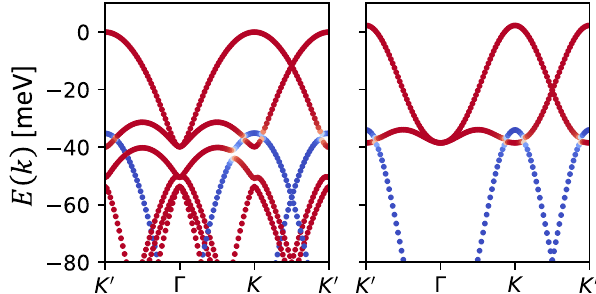
FIG. 9. Left panel: continuum-model noninteracting bands for AB-stacked MoTe 2 = WSe 2 valence bands [33]. Right panel: tight- binding model approximation, near noninteracting band inver- sion. The tight-binding model captures the qualitative features of the first bands of each valley and layer. Color indicates layer content: MoTe 2 is red, and WSe 2 is